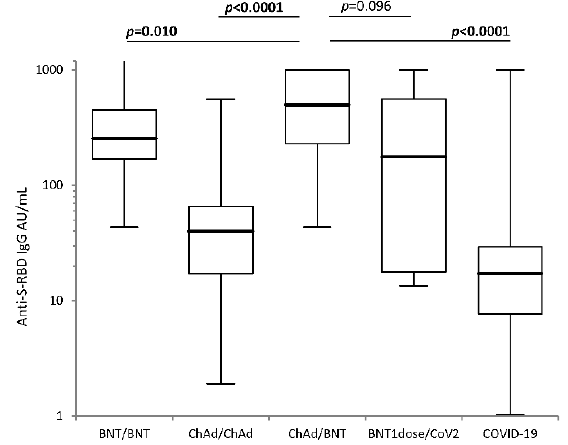
Figure 1. Comparison of SARS-CoV-2 Anti-S-RBD IgG titers between groups of vaccinated and convalescent subjects. Comparison of SARS-CoV-2 serum anti-S-RBD IgG (AU/mL) four weeks after booster (T FULL ) or in convalescent subjects. BNT/BNT: two doses of BNT162b2; ChAd/ChAd: two doses of ChAdOx1 nCoV-19; ChAd/BNT: first dose ChAd, second dose BNT; BNT1dose/CoV2: BNT first dose, then SARS-CoV-2 infection (no vaccine booster); COVID-19: convalescent. The levels among group of COVID-19 convalescent were significantly lower than BNT/BNT, ChAd/BNT, ChAd/ChAd ( p = 0.007) and BNT1dose/CoV2 ( p = 0.039). Median values of S-RBD-protein IgG were slightly higher in female vs. male subjects across all groups, being statistically significant only in the ChAd/ChAd (51.73 AU/mL vs. 19.89 AU/mL, p = 0.015).